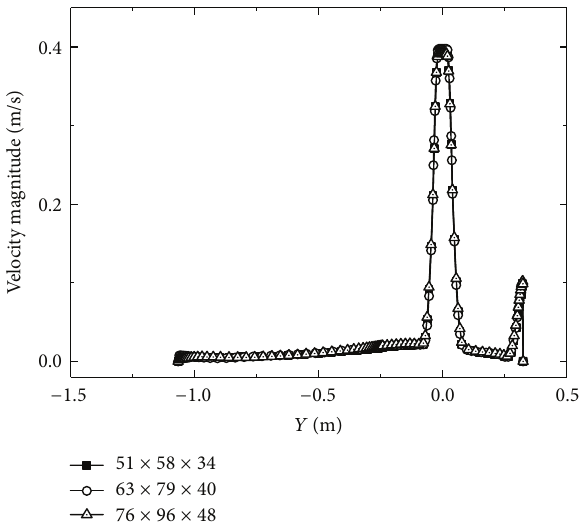
Figure 7: Volume fraction of flow for the studied cases. Table 1: RTD parameters in the tundish